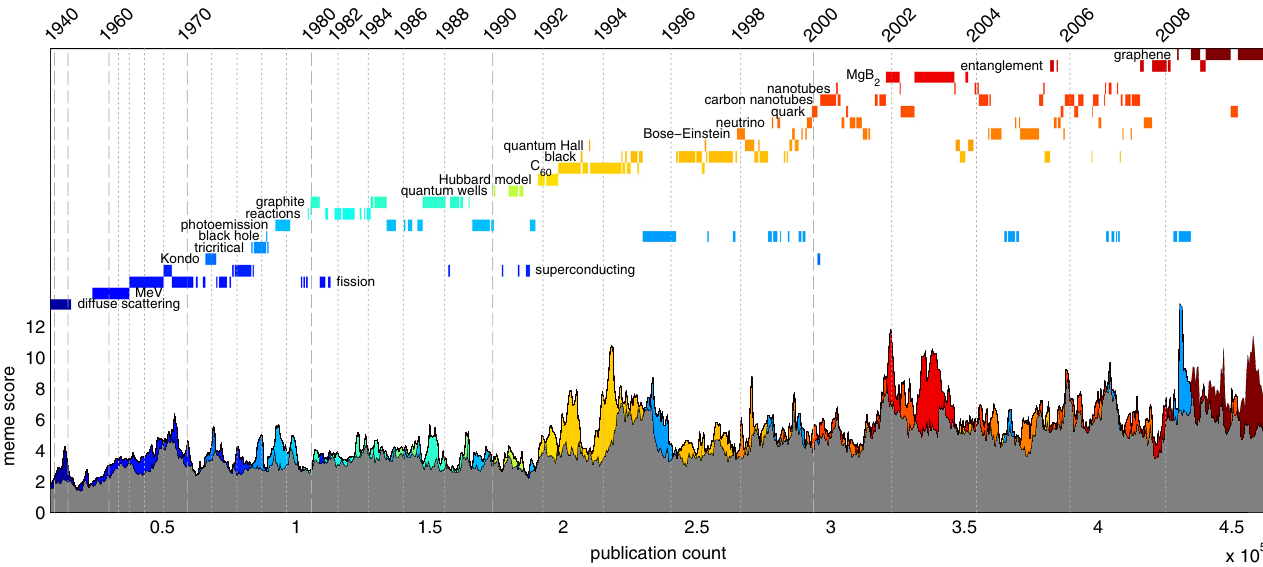
FIG. 5. Time history of top physics memes based on their meme scores obtained from the American Physical Society data set. The time axis is scaled by publication count. Bars and labels are shown for all memes that top the rankings for at least 10 out of the displayed 911 points in time. The gray area represents the second-ranked meme at a given